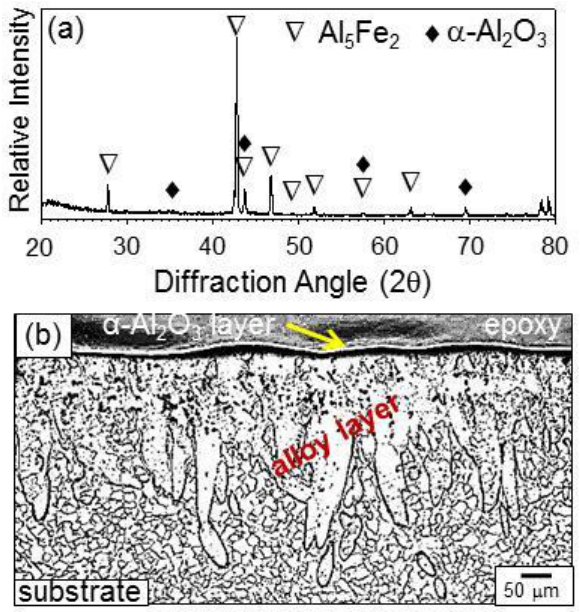
Figure 2. Al hot-dipped carbon steel after corrosion at 600 °C for 50 h in N 2 /0.1% H 2 S gas: ( a ) XRD pattern; ( b ) etched cross-sectional OM image.